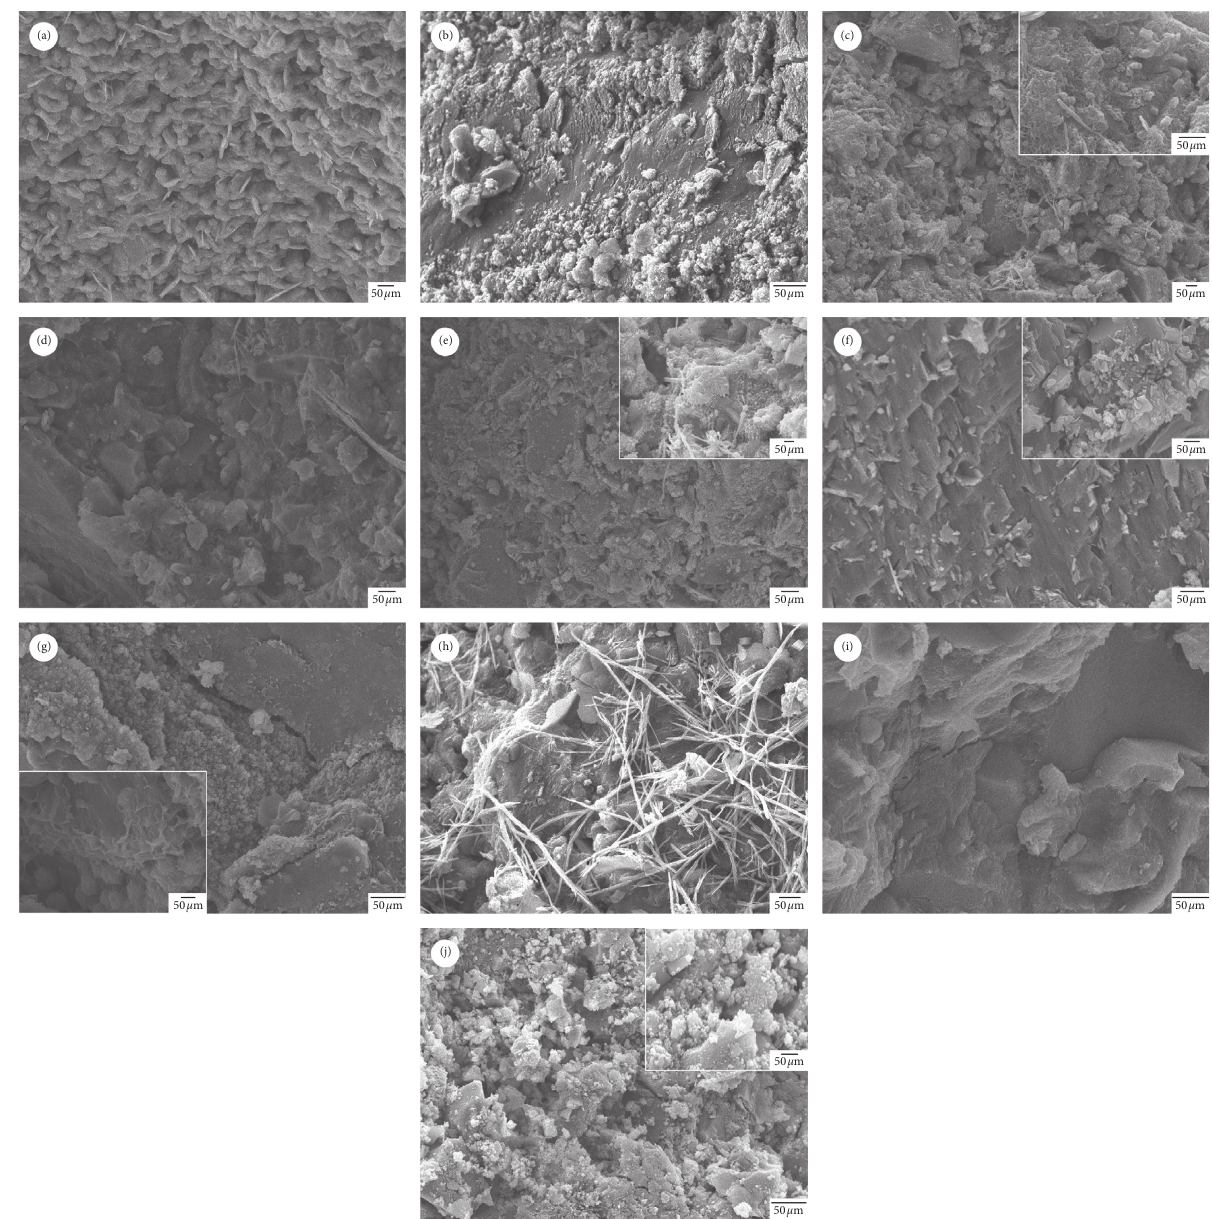
Figure 7: SEM images of partial GGBS-incorporating 3 d and 28 d mortars: (a) 3 d C10T23W45; (b) 28d C10T23W45; (c) 3d C20T23W45; (d) 28d C20T23W45; (e) 3d C30T23W45; (f) 28 d C30T23W45; (g) 3 d C20T40W45; (h) 28d C20T40W45; (i) 3d C20T23W35; (j) 28d